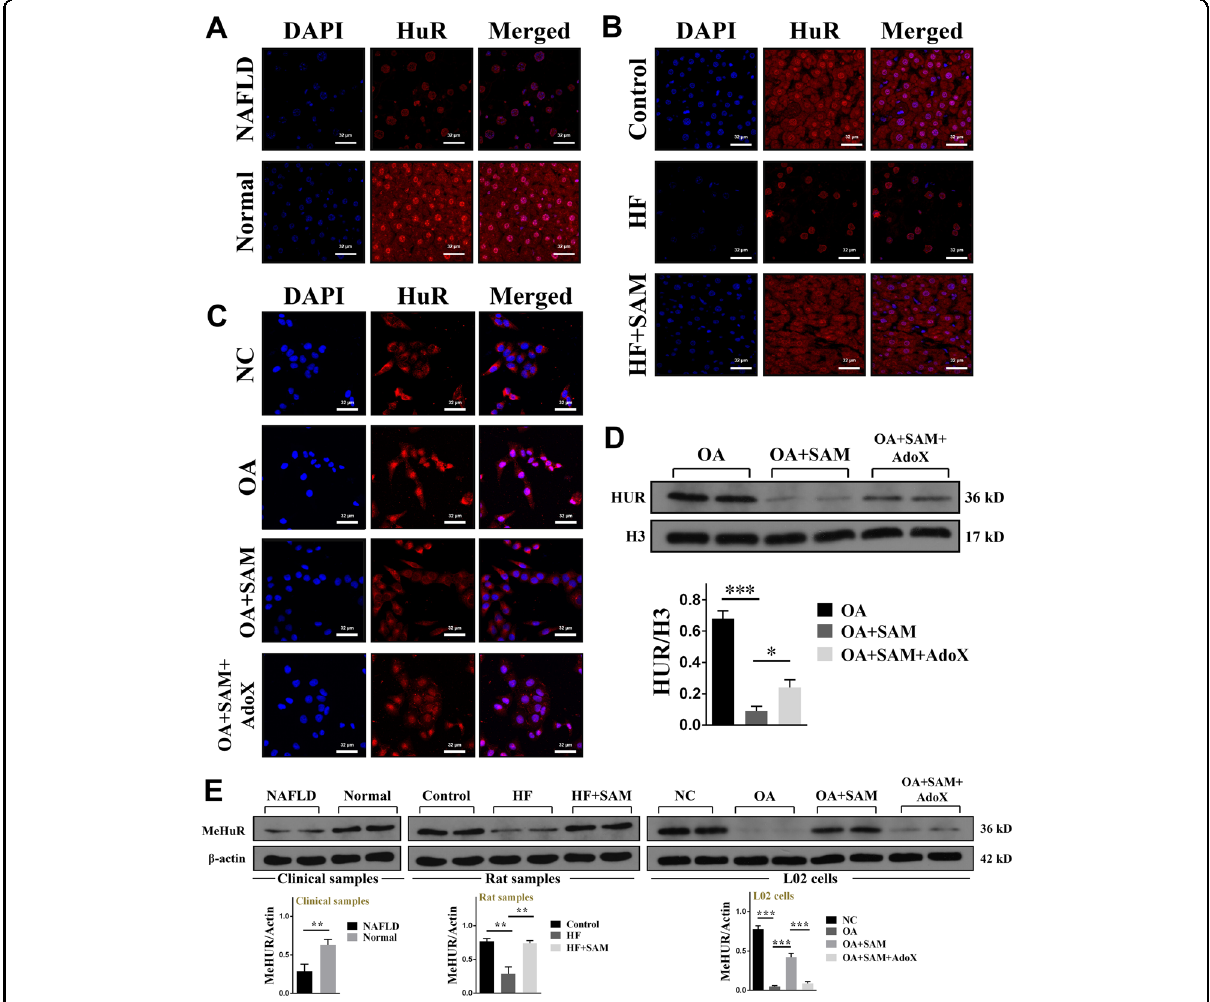
Fig. 4 The methylation status and subcellular localization of the HuR protein were altered in NAFLD. A Detection of the HuR protein in NAFLD and normal liver tissues by immuno fl uorescence staining (bar = 32 μ m). B Detection of the HuR protein in rats from the control, HF, and HF plus SAM groups by immuno fl uorescence (bar = 32 μ m). C Subcellular localization of the HuR protein in L02 cells treated with OA, OA plus SAM, and OA plus SAM plus AdoX, as determined by immuno fl uorescence (bar = 32 μ m). D Nuclear levels of the HuR protein in L02 cells after treatment with OA, OA plus SAM, or OA plus SAM plus AdoX, as determined by western blotting. The error bars are the SDs ( n = 3). E Methylated HuR protein in normal, NAFLD, or SAM-treated liver tissues or cells in vivo and in vitro, as determined by western blotting. The error bars are the SDs ( n = 3). * P < 0.05, ** P < 0.01, *** P <